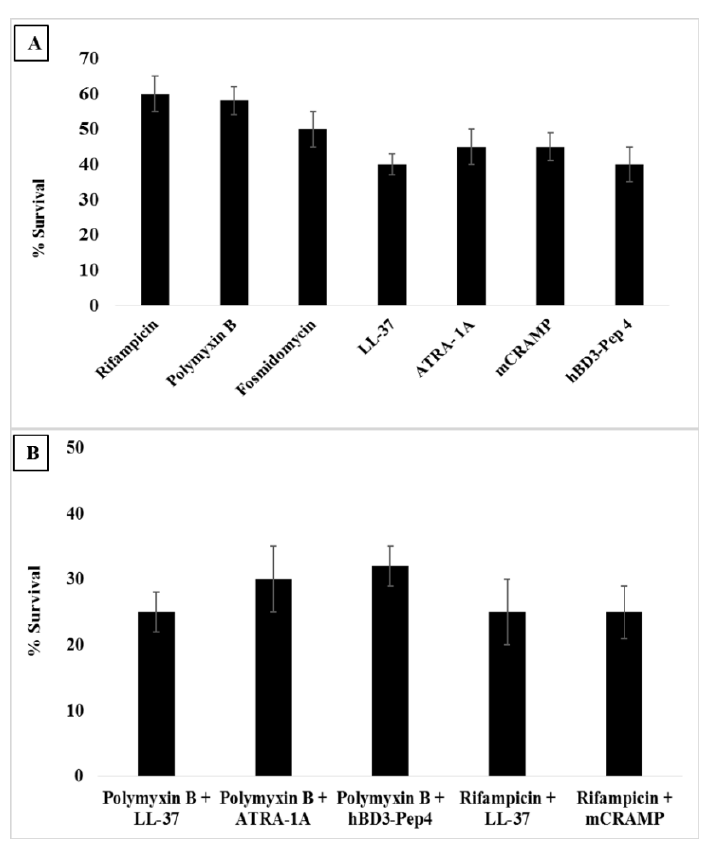
Figure 4. Intracellular killing of mycobacteria in macrophages. Macrophages were infected with M. smegmatis for 12 h and then incubated with antibiotics, antimicrobial peptides, and peptide-drug combinations. Macrophages infected with bacteria alone were used as a control. Cells were lysed, and bacterial intracellular survival was determined by CFU assay. ( A ) Intracellular survival of M. smegmatis after treatment with antibiotics or antimicrobial peptides; p ≤ 0.05 significantly different compared to untreated; ( B ) Intracellular survival of M. smegmatis after treatment with peptide-drug combination. Experiments were performed in triplicate ( n = 3). Means ± the SD are shown; p ≤ 0.05 significantly different compared to